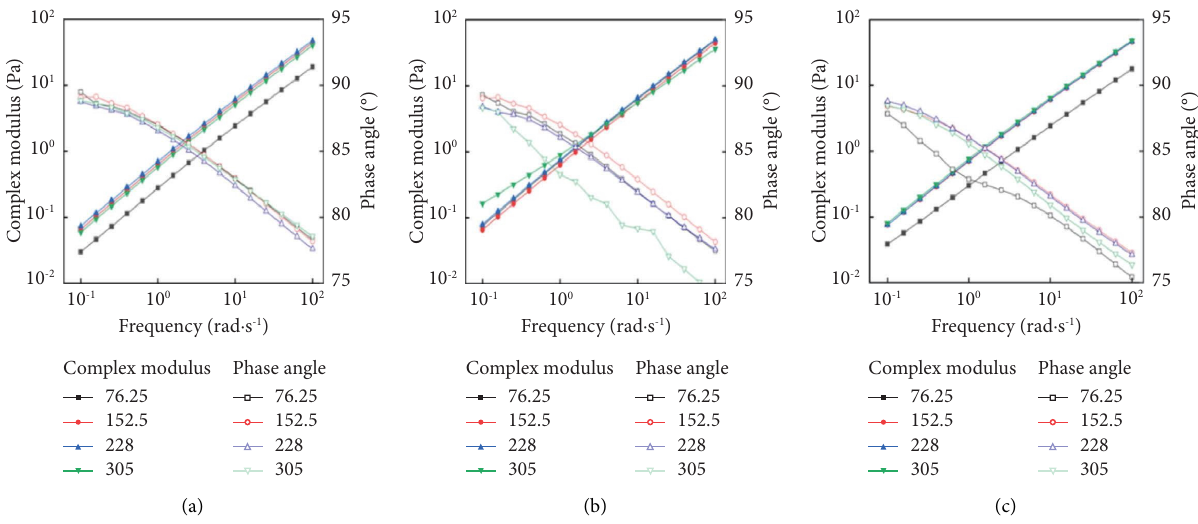
Figure 6: Variation curves of G ∗ and δ of diferent types of asphalt with UV aging time at 60 ° C. (a) 70#. (b) T770. (c)